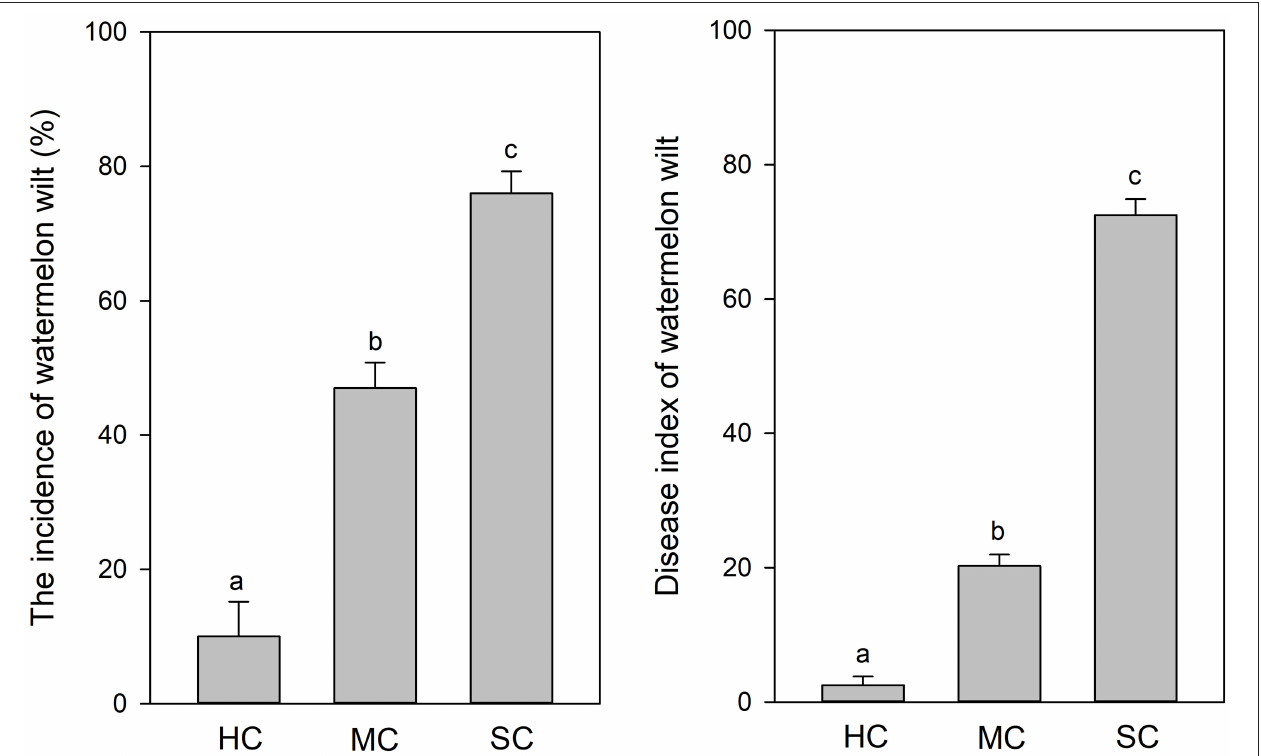
FIGURE 1 | Incidence and severity of watermelon wilt in the greenhouse with four replicate experimental plots of every cultivar. Each experimental plot had 25 watermelon plants. HC, highly resistant cultivar; MC, moderately resistant cultivar; SC, susceptible cultivar. Different letters indicate significant difference among different cultivars ( n = 100, P <